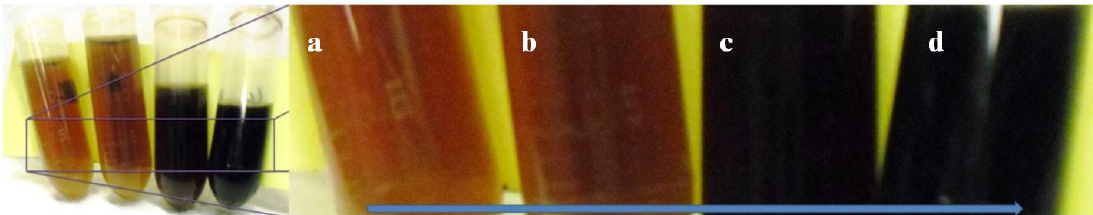
Figure 7. All samples contained 10 mg AIBN, 250 µL of 10 g/L DA, 60 µL of 1.5 M NaOH.